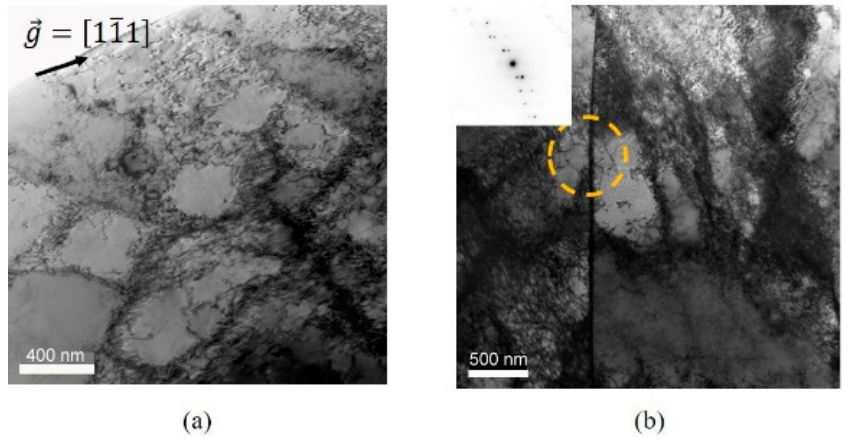
Figure 11. TEM images of grains of fractured sample 4 (d = 4.0 µm), containing dislocation cells. Accumulation of geometric dislocation cells of similar size in a single grain ( 𝑔⃗ = (cid:4670)11(cid:3364)1(cid:4671)) ( a ) and contiguous grains displaying dislocation cells with a high density of dislocations ( b ).